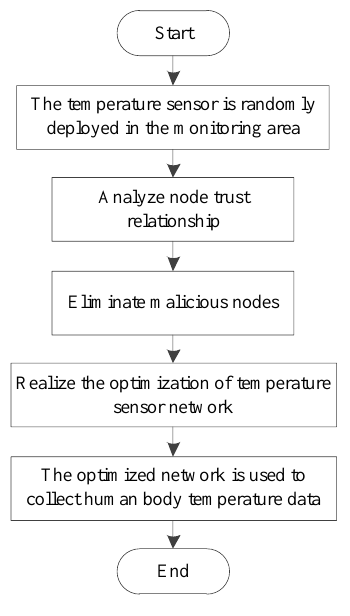
Figure 1. Human body temperature data collection